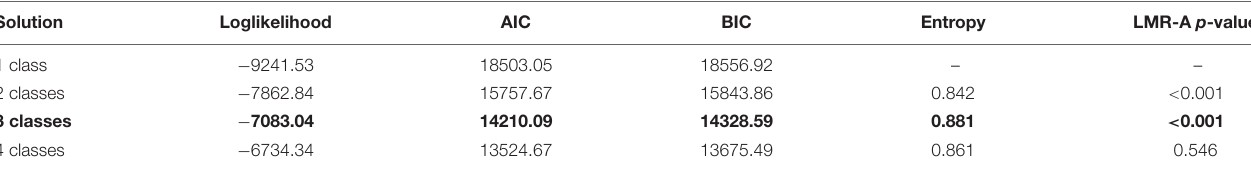
TABLE 3 | Model fit indices of latent class analysis.